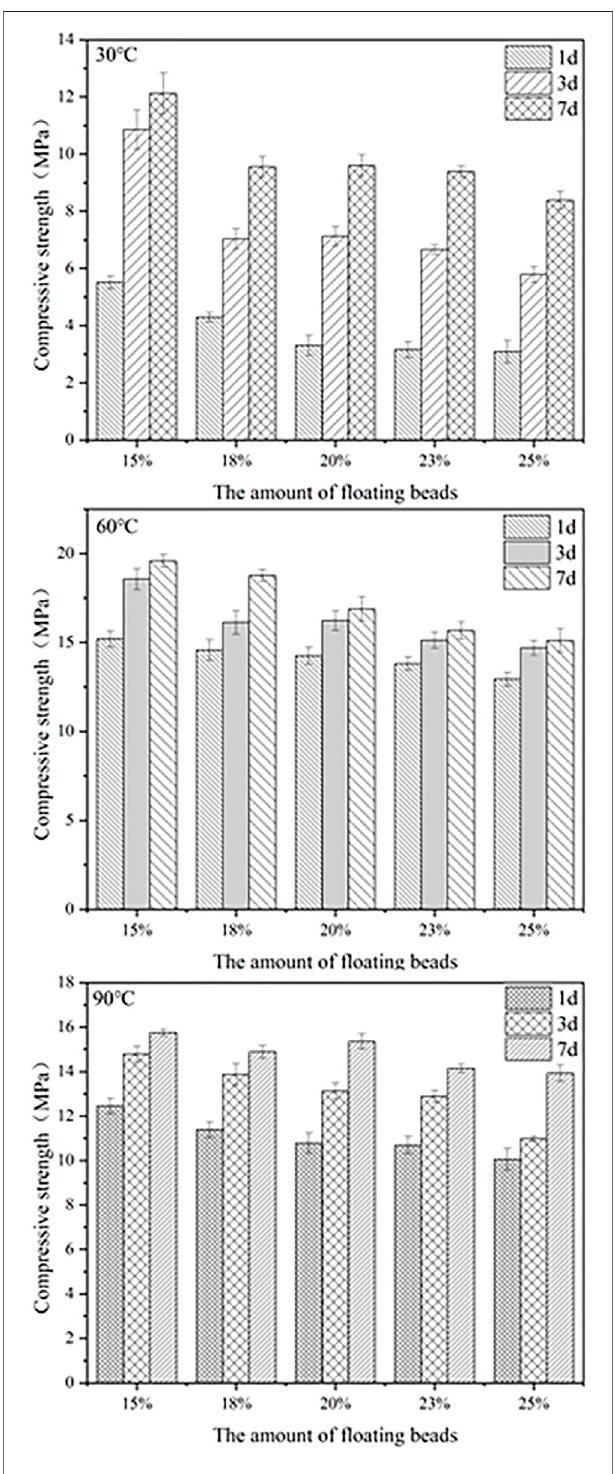
FIGURE 4 | Compressive strength of cement